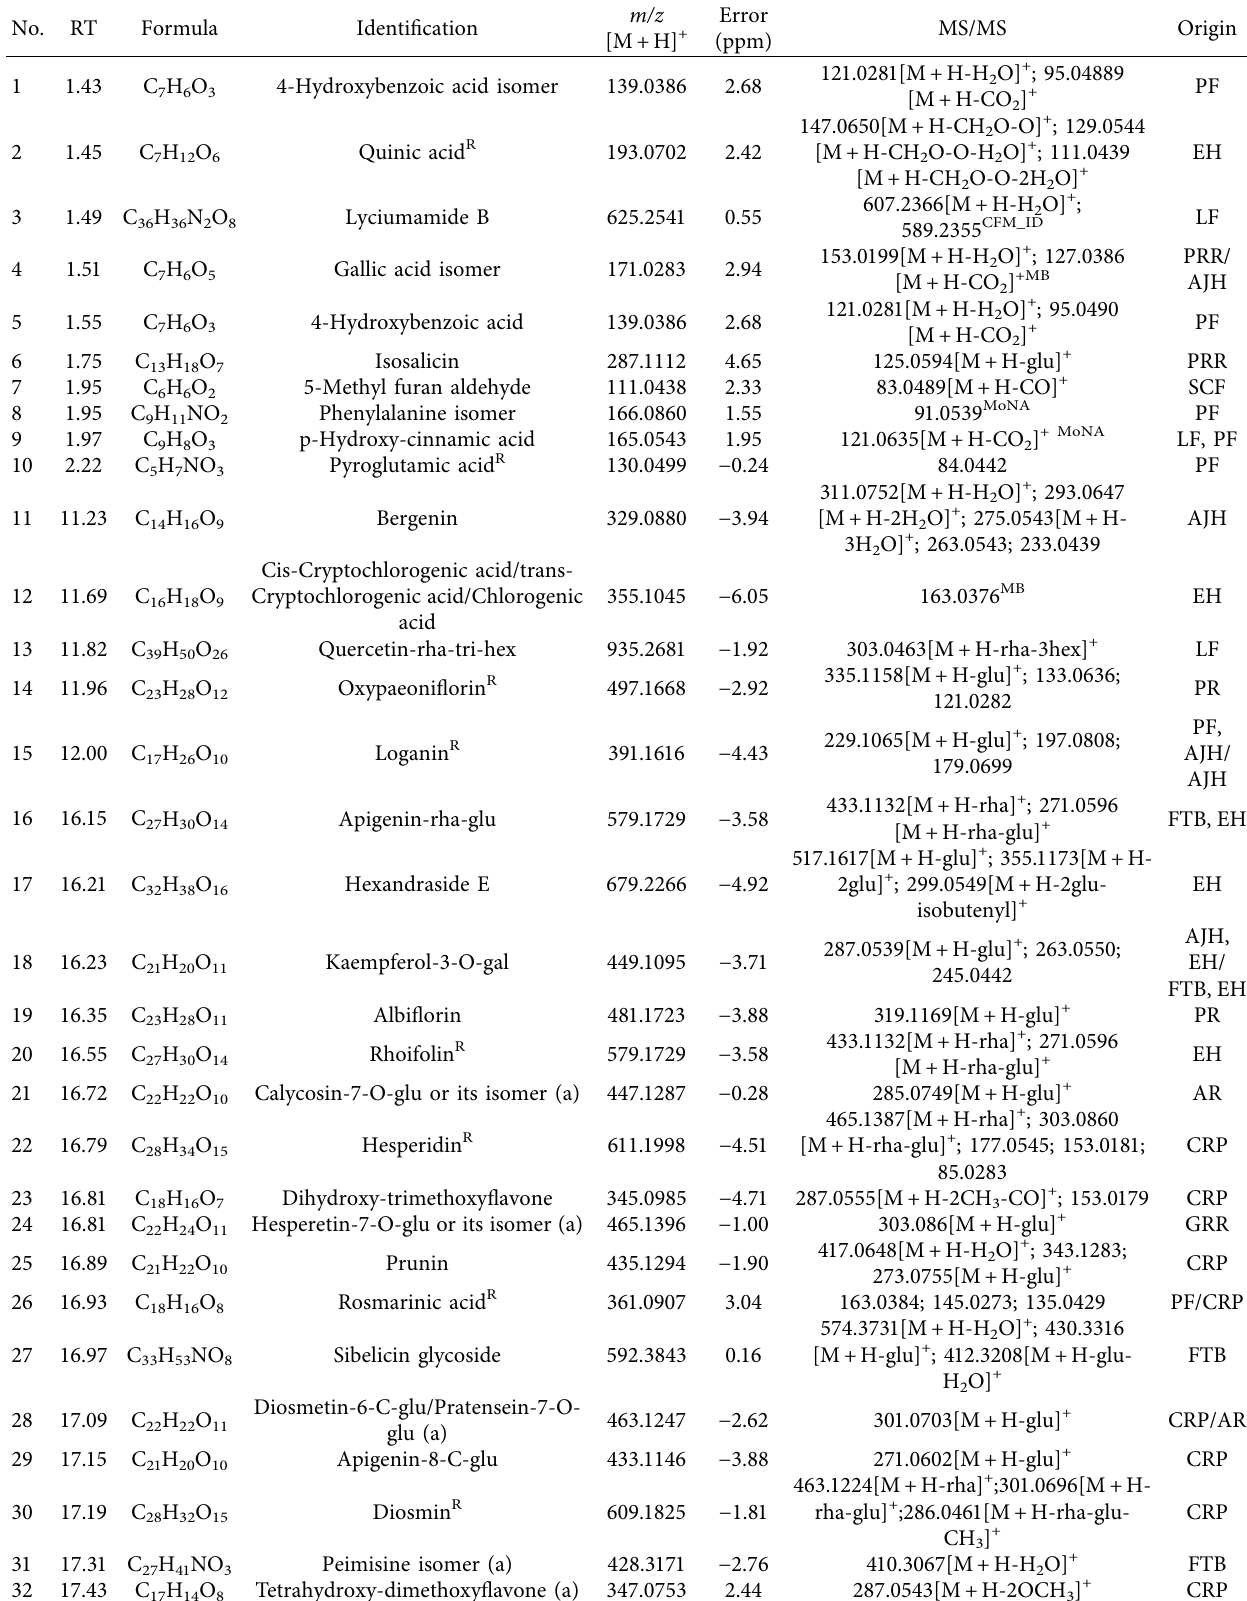
Table 1: Chemical identification of BYF by UHPLC-Q-extractive Orbitrap